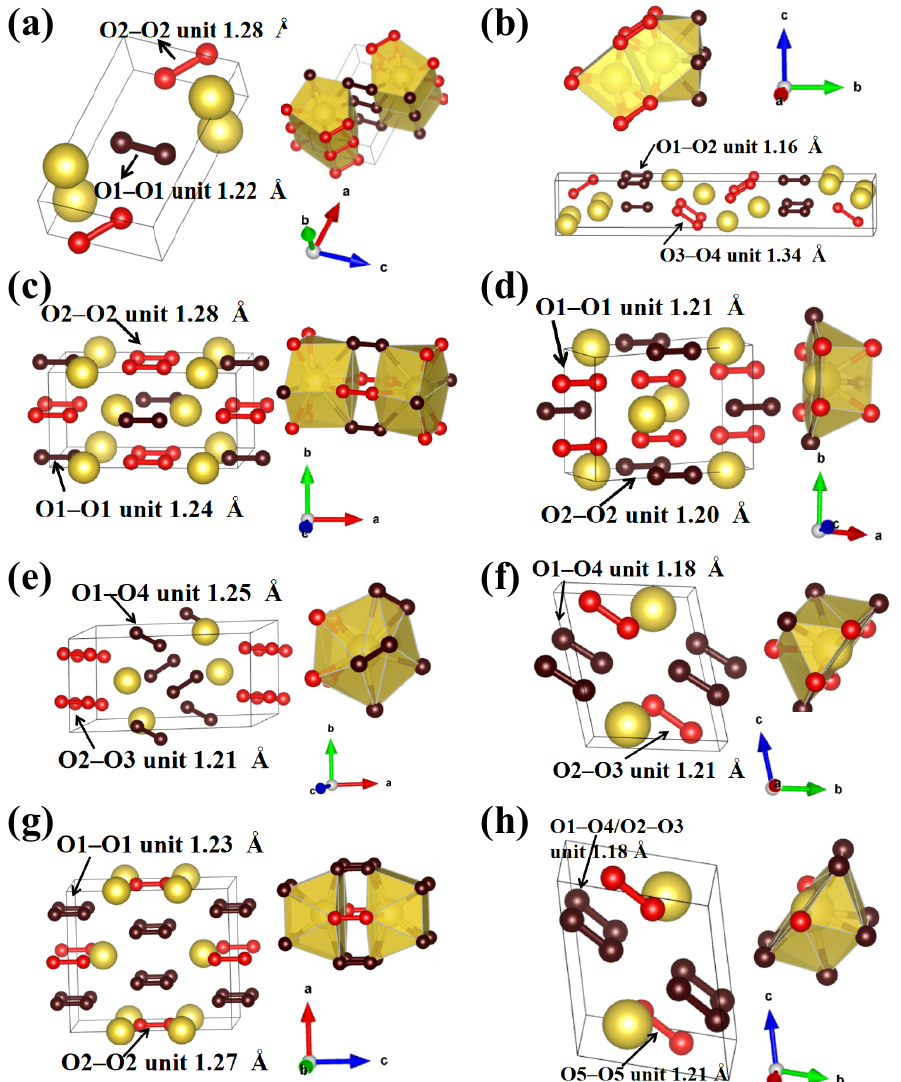
Figure 2. Crystal structures of the predicted O-rich Na–O compounds: ( a ) P 2 /m NaO 2 at 200 GPa; ( b ) Cmc 2 1 NaO 2 at 300 GPa; ( c ) Immm NaO 3 at 50 GPa; ( d ) C 2 /m NaO 3 at 300 GPa; ( e ) P 2 1 /c NaO 4 at 120 GPa; ( f ) P- 1 NaO 4 at 300 GPa; ( g ) Immm NaO 5 at 50 GPa; ( h ) P- 1 NaO 5 at 300 GPa. Small spheres (dark and light red) represent O atoms; yellow spheres denote Na atoms. An Im 2 m phase of NaO 3 containing unusual ozone anions at ambient pressure was NaO 4 stabilized in a P 2 1 /c structure (4 f.u./cell) above 66.8 GPa. The structure had previously reported [11]. Our calculations found two new NaO 3 phases ( Immm (2 f.u./cell) one Na atom at the 4e position and four inequivalent O atoms at the 4e sites. The O–O distances were 1.21 Å and 1.25 Å at 120 GPa. Each Na was surrounded by 11 O atoms, forming an irregular polyhedron (Figure 2e). At 127 GPa, the P 2 1 /c structure